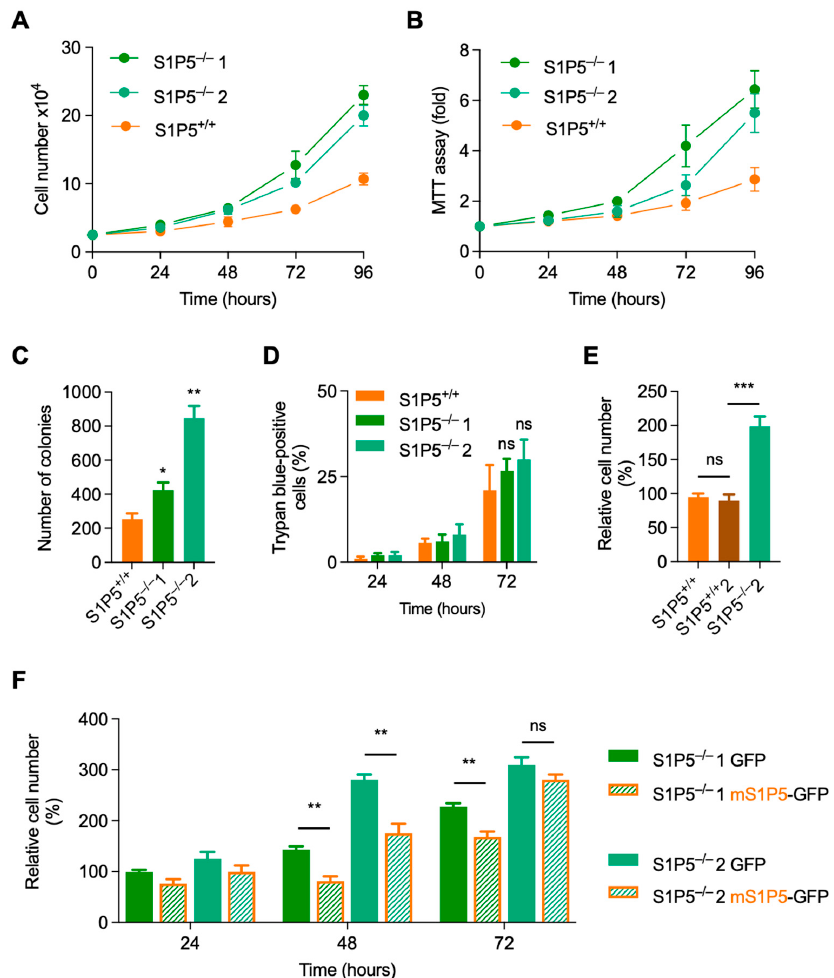
Figure 4. Growth properties of immortalized S1P5-deficient cells. ( A ), S1P5 +/+ and S1P5 − / − cells were plated at equal cell number and the cell number was counted daily over four days. Results are representative from four independent experiments performed in triplicates from MEFs at passages 18 to 22. ( B ), cell survival of S1P5 +/+ and S1P5 − / − MEFs (passages 18–22) was assessed by MTT assays at the indicated times after seeding. Results are representative from three independent experiments performed in triplicates. ( C ), colony formation capacity of immortalized S1P5 +/+ and S1P5 − / − MEFs between passages 18–22. Low number of cells were plated and allowed to grow for 10 days. Cells were then fixed and stained with crystal violet to visualize colony formation. Graph shows the means of colony number ± SEM from three independent experiments performed in triplicates (*, p < 0.0357; **, p < 0.0017). ( D ), cell death/viability was evaluated by trypan blue staining. S1P5 +/+ and S1P5 − / − cells were plated at equal cell number and the number of trypan blue-positive cells was counted at the indicated time points. Results are means ± SEM from three independent experiments performed in triplicates. (ns, not significant). ( E ), equal number of S1P5 +/+ , S1P5 +/+ clone 2 (S1P5 +/+ 2) and S1P5 − / − 2 cells were plated and the cell number was counted 72 h later. Results represent means of the relative number of cells ± SEM from three independent experiments performed in triplicates (***, p < 0.0007; ns, p = 0.6279). ( F ), S1P5 rescues the S1P5 − / − phenotype. Immortalized MEFs S1P5 − / − clone 1 and clone 2 were transiently transfected with empty vector (GFP) or a vector containing mS1P5-GFP. The total cell number was evaluated at different post transfection times. Results repre- sent means of the relative number of cells ± SEM of three independent experiments performed in triplicates (**, p < 0.0058; **, p < 0.0099; **, p < 0.0079; ns, p = 0.1879).